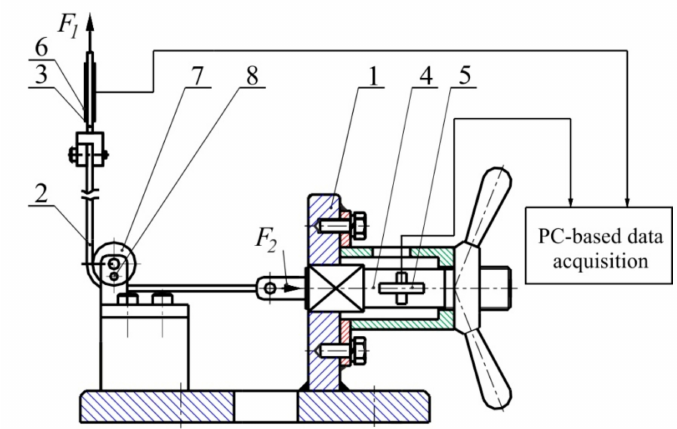
Figure 17. Schematic view of the testing device: 1—device frame, 2—specimen, 3 and 4—tension members, 5 and 6—extensometers, 7—working roll, 8—fixing